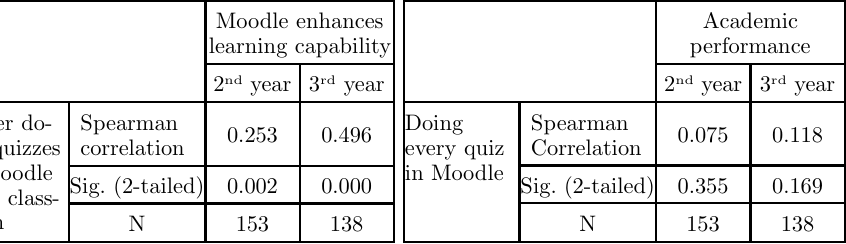
Table 5. Relationship between the preference for doing quizzes in Moodle and Moodle’s enhancement of learning capability (left); and between doing every quiz in Moodle and academic performance